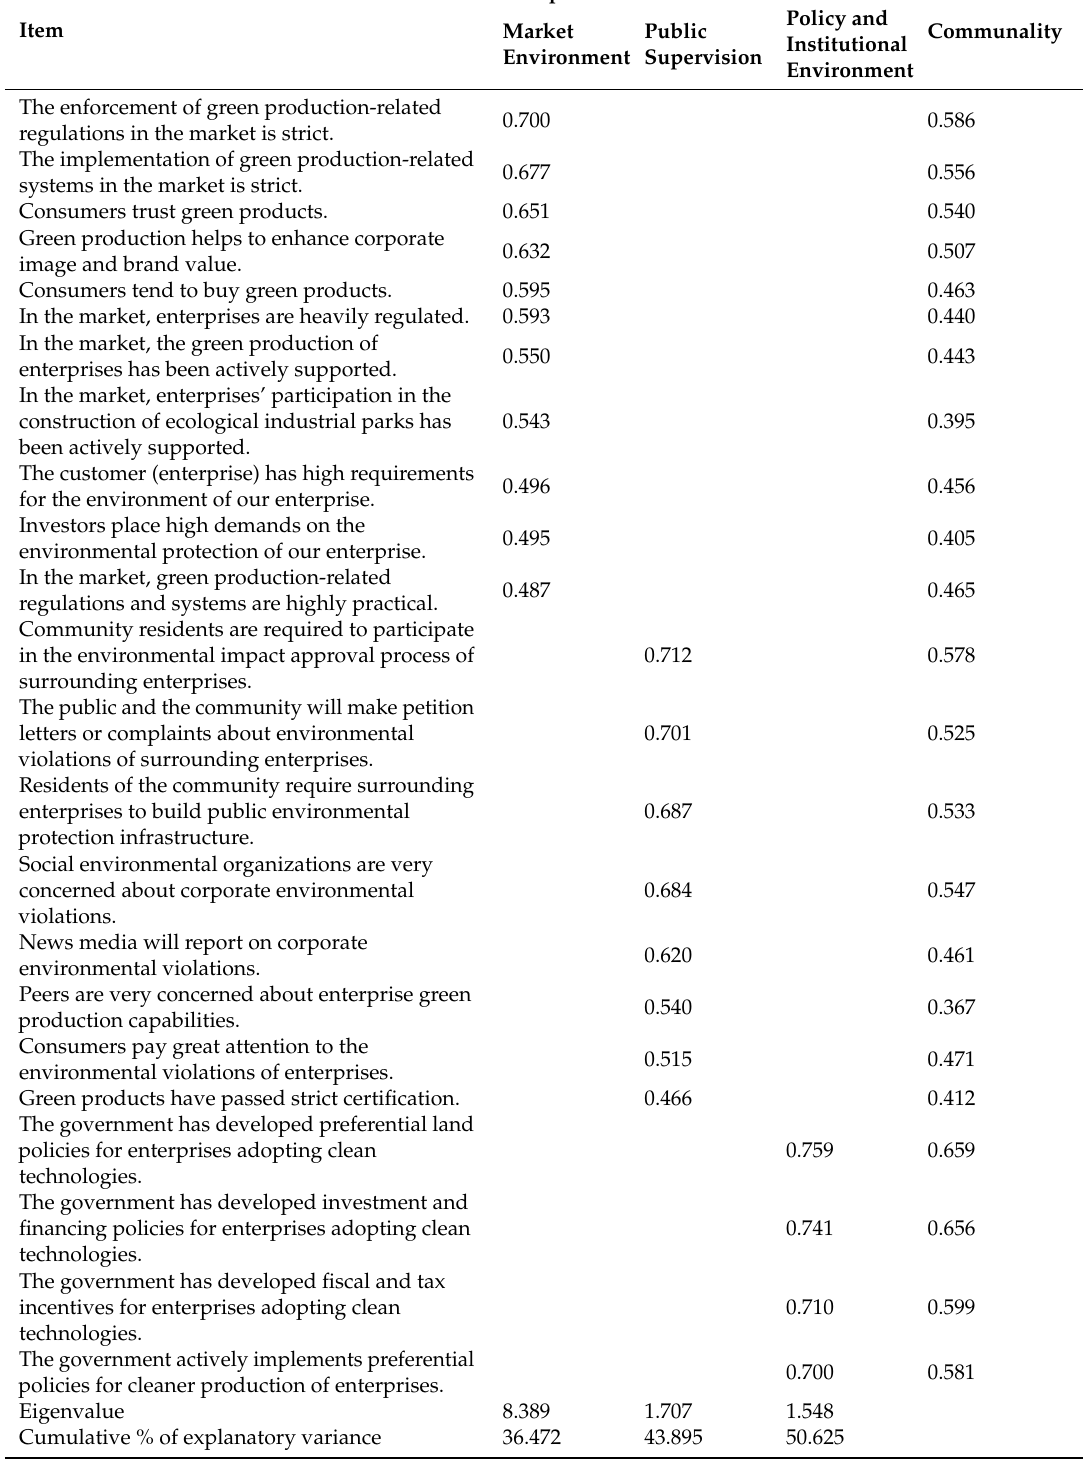
Table 6. Components and factor loadings of the external factors (EFs) sub-scale ( N = 853).